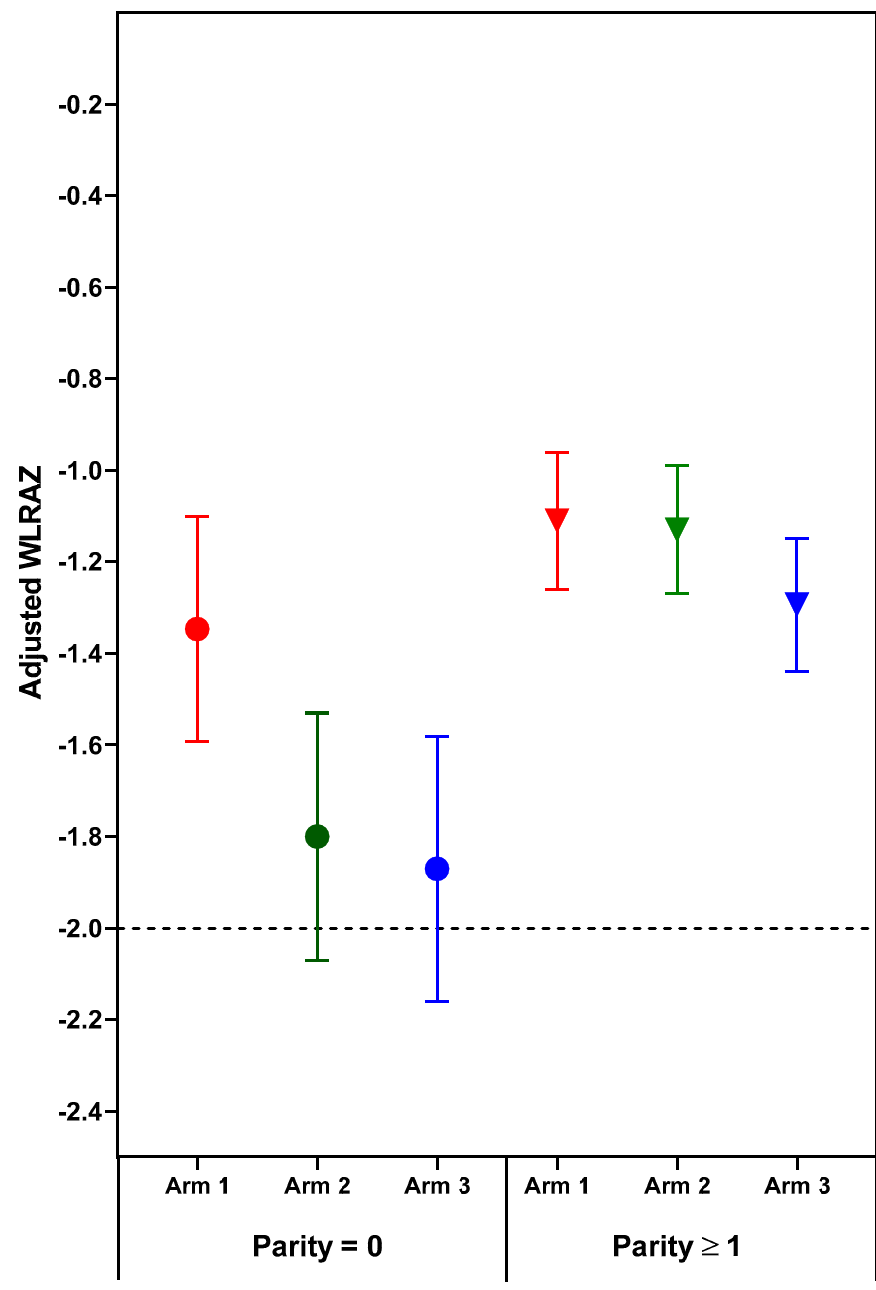
Figure 1. Adjusted mean (95% confidence interval) weight to length ratio-for-age z -scores (WLRAZ) of neonatal outcomes by treatment arm and parity. Horizontal line at WLRAZ − 2 depicts weight to length deficit for diagnosis of wasting. Circles indicate parity = 0; Triangles indicate parity ≥ 1.